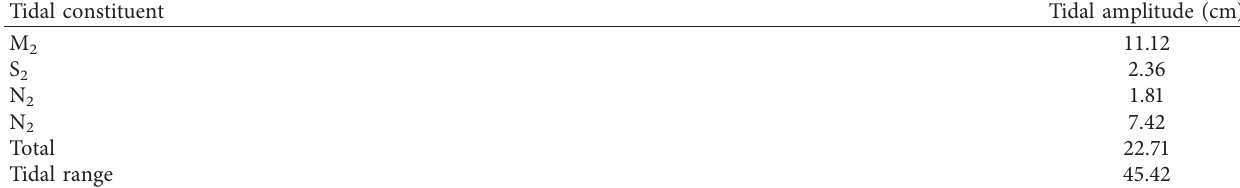
Figure 8: Amplitude in cm of M 2 tidal constituent of (a) larger local area surrounding the island for comparison and (b) global coverage for comparison. Table 5: Tidal constituents and their respective tidal amplitudes (cm) surrounding the island.